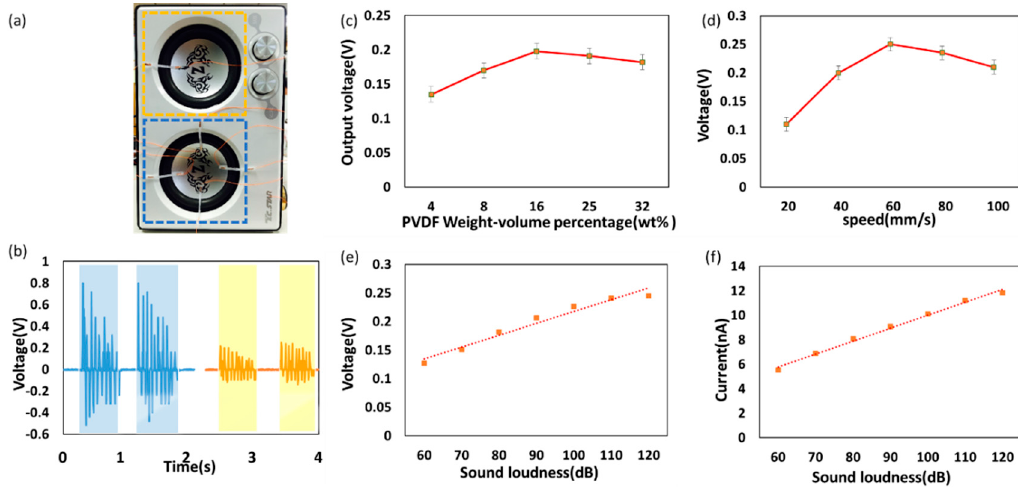
Figure 3. The performance of sensing sound. The ISSE is clamped on a loudspeaker to test the sound-sensing capability as illustrated in ( a ) optical photo. ( b ) The relative voltage output detected by four ISSE (blue dotted rectangle) and one ISSE (blue dotted rectangle). ( c ) The relative voltage output as a function of the PVDF solution concentration from 8% to 32%. The x-y stage speed is fixed at 60 mm/s. ( d ) The relative voltage output as a function of the x-y stage speed from 20 to 100 mm/s. The PVDF solution concentration is fixed at 16%. The occurrence of voltage peak coincides with the NFES parameters of 16% PVDF solution and at 60 mm/s motion speed, which is the defect-free morphology and higher quality. The recorded ( e ) relative voltage output and ( f ) current output. Both electrical signals increase with the increase of the sound loudness of the loudspeaker.